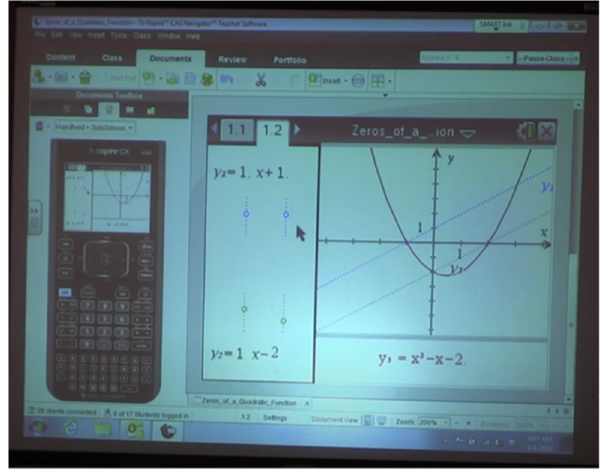
Figure 2. Image of Ms. Joiner’s computer screen emulating the student’s graphing calculator on Day 2 (25 February).